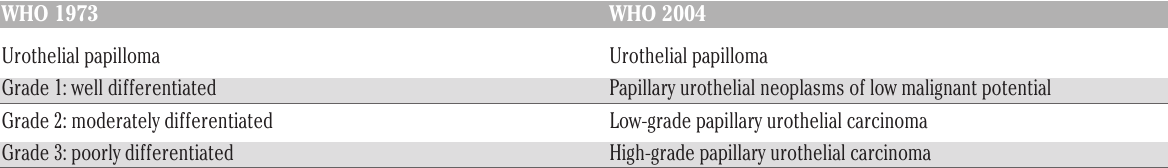
Table 1. World Health Organization (WHO) grading of bladder tumor in 1973 and 2004.